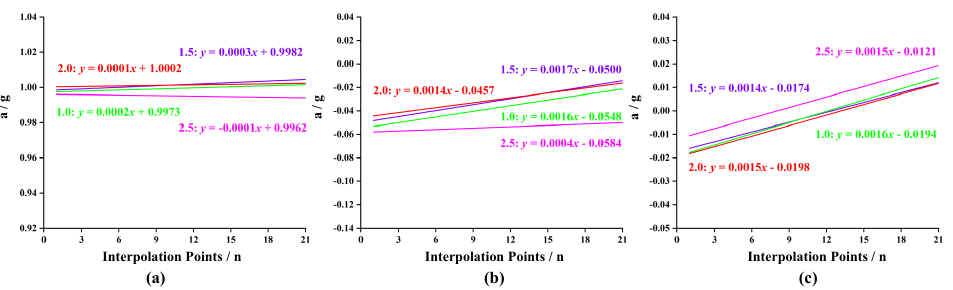
Figure 11. Results of the linear fit to the acceleration variation on the interpolation points. The fit results are presented for each of the four sets regarding chip thickness on the same axis. ( a ) Fitting results on the X -axis. ( b ) Fitting results on the Y -axis. ( c ) Fitting results on the Z